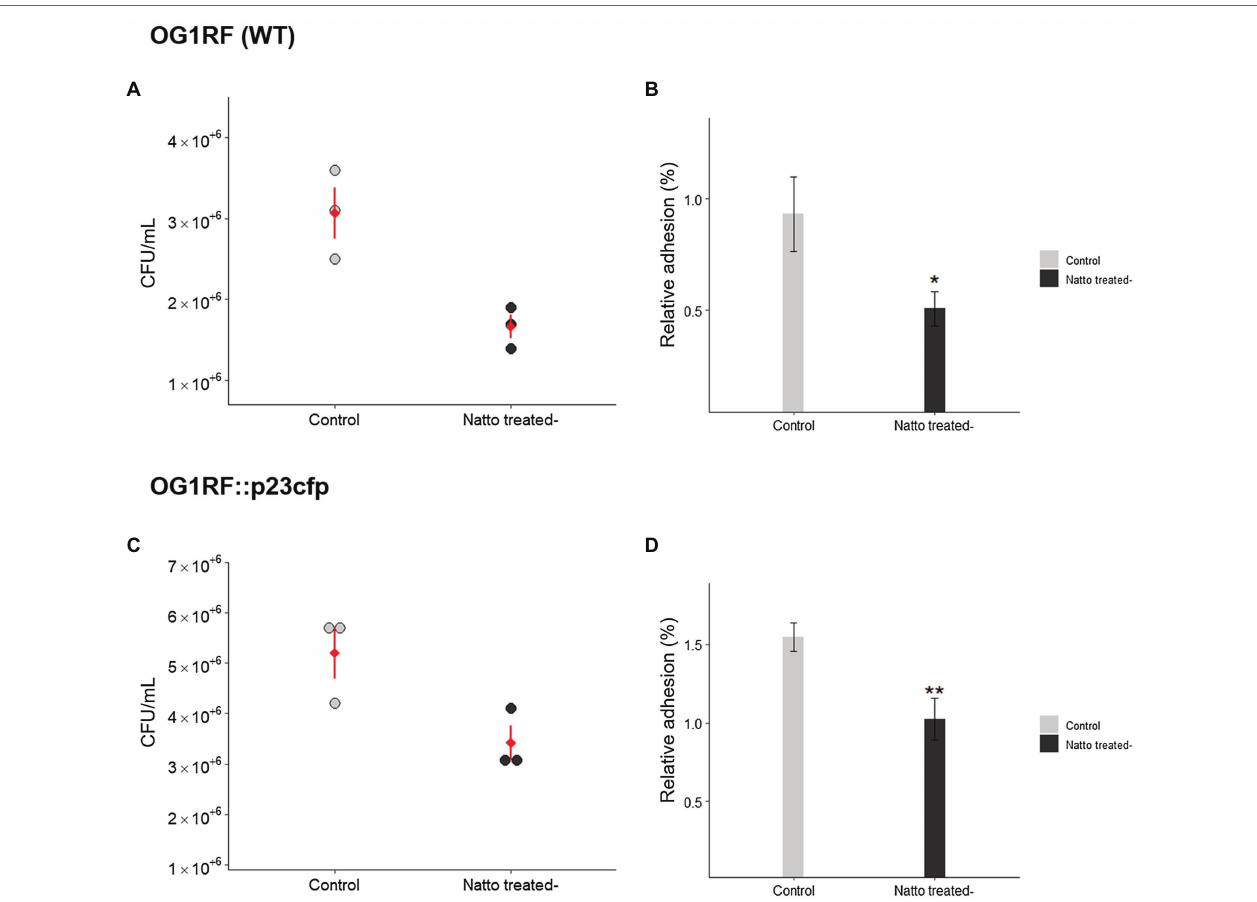
FIGURE 1 | Bacillus subtilis natto supernatant affects the adhesion of Enterococcus faecalis cells into human intestinal Caco-2 cell monolayers. The concentrations (A,C) (CFU/ml) and relative adhesion(%) (B,D) of E. faecalis OG1RF (WT) and OG1RF::p23cfp cells to Caco-2 cell monolayers after 3 h in an in vitro bacterial adhesion assay with or without B. subtilis natto supernatant treatment (10%, v/v). In (A) and (C) , each dot in the figures represents a replicate, and the red diamonds with red lines indicate the means ± SDs ( n = 3). In (B) and (D) , the data are presented as the means ± SDs ( n = 3). * p < 0.05 and ** p < 0.01 compared with each negative control group (Student’s t